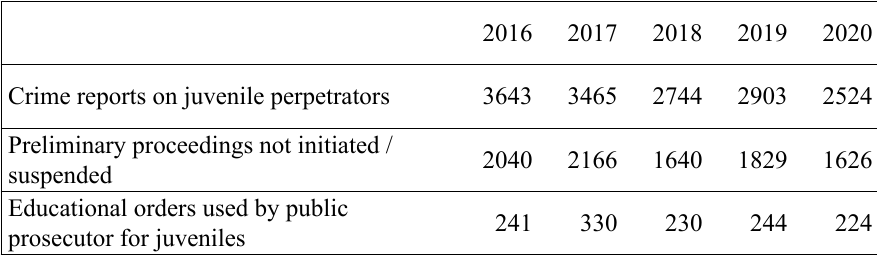
Table 1 . Public prosecutor’s office for juveniles statistics in Serbia from